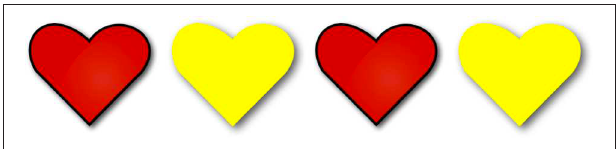
FIGURE 9 | Image corresponding to a GAP context. The first and third hearts are red, while the second and fourth hearts are yellow. If used on a homogeneity target trial, this image would accompany either the positive Les coeurs sont rouges “The hearts are red” or the negative Les coeurs ne sont pas rouges “The hearts are not red.” If used on an incomplete description control trial, this image would accompany the sentence Certains coeurs sont rouges “Some hearts are red.” If associated with a partial truth control, this image would accompany the positive Tous les coeurs sont rouges “All the hearts are red.” Finally, if associated with a scope ambiguity control, this image would accompany the negative Tous les coeurs ne sont pas rouges “Not all the hearts are